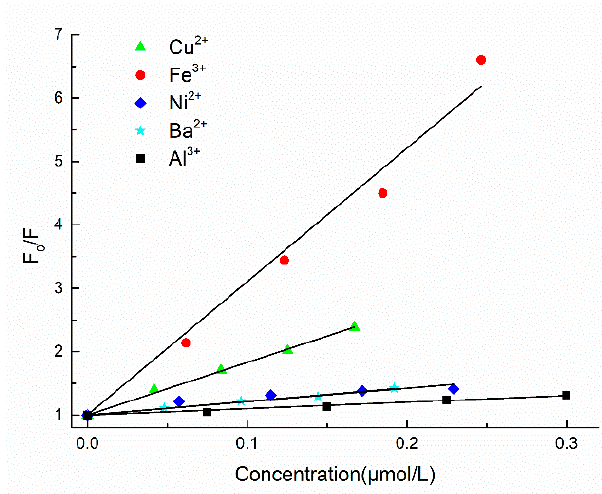
Figure 13. Stern-Volmer curves for quenching of LOPC fluorescence by Cu 2+ , Ba 2+ , Al 3+ , Fe 3+ and Ni 2+ ions.